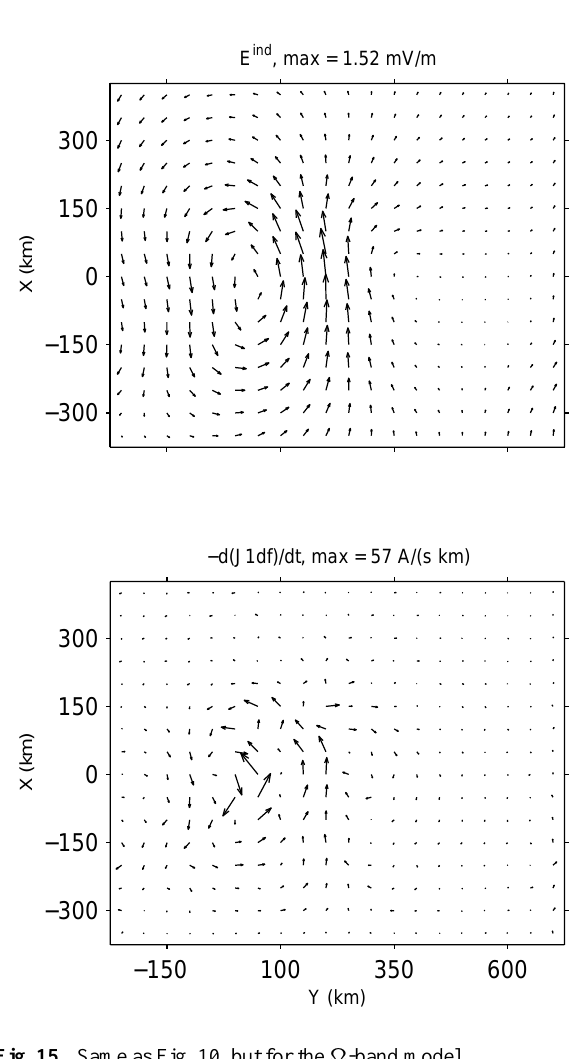
Fig. 15. Same as Fig. 10, but for the (cid:127) -band